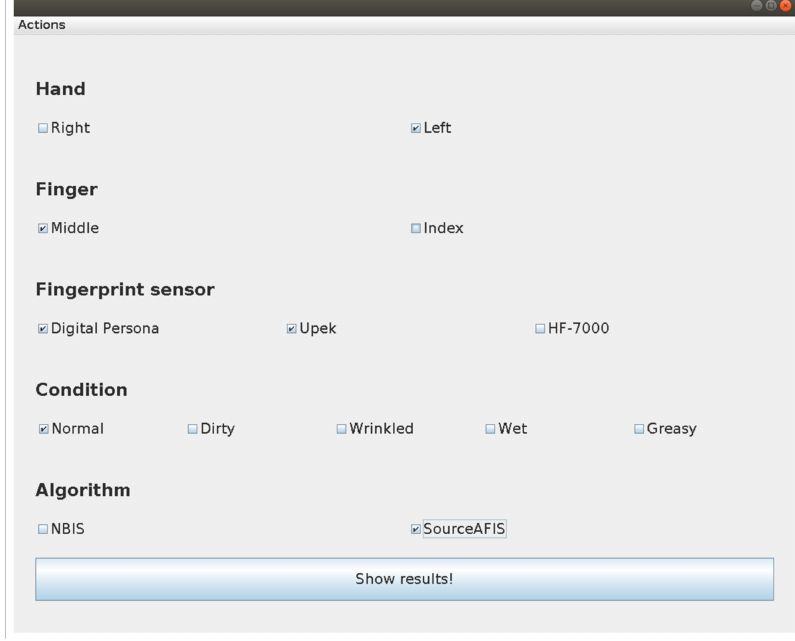
Figure 6. Application form for choosing evaluation parameters.